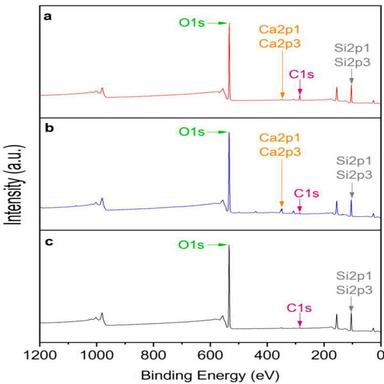
XPS spectra of silica from SCB (a), CS (b), and RH (c).